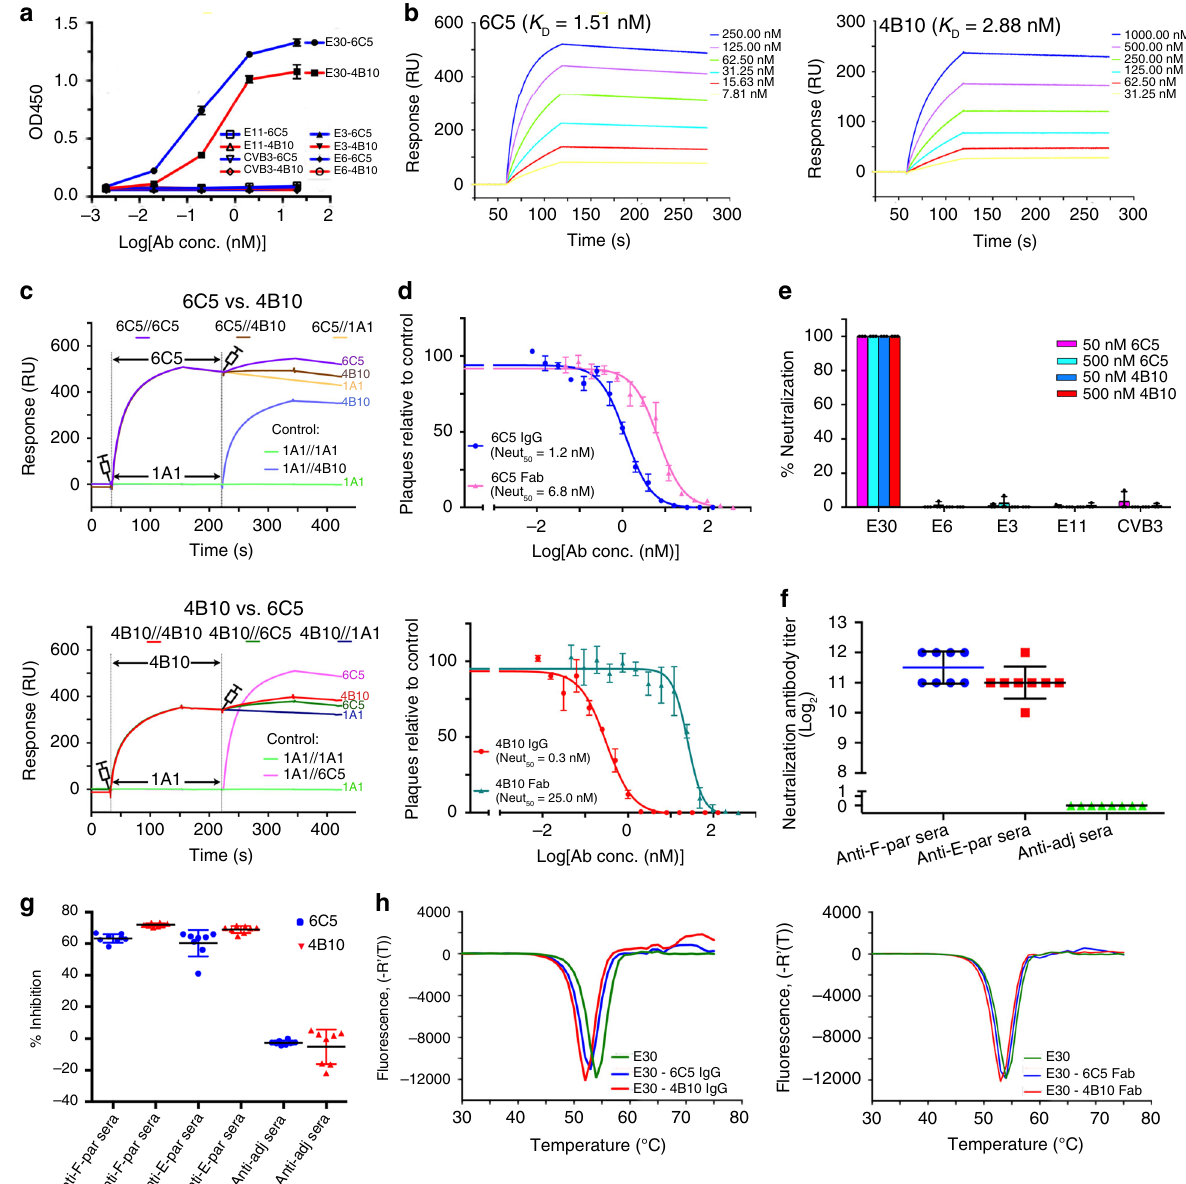
Fig. 1 Characterizations of the MAbs 6C5 and 4B10. a Dose-dependent binding analysis of MAbs (6C5 and 4B10) against representative enterovirus B members by ELISA. Each plot represents the mean of OD450 values from triplicate wells. Error bars represent mean ± SD. b BIAcore SPR kinetic pro fi le of MAb 6C5 (left) and 4B10 (right) against E30 virus. The binding af fi nity K D (equilibrium dissociation constant, K D = K d / K a , where K d and K a represents the dissociation rate constant and association rate constant, respectively) values were obtained by using a series of MAb concentrations and fi tted in a global mode in each sensorgram. c Competitive binding between 6C5 and 4B10. In the upper panel, MAb 6C5 was injected fi rst, followed by the second injection of 4B10 or 1A1 speci fi c to E6 as control. In the lower panel, 4B10 was injected fi rst, which was followed by 6C5 or 1A1; the control groups are carried out as the other lines exhibit. d Neutralization of E30 by 6C5 (top) and 4B10 (bottom) using plaque-reduction neutralization test (PRNT). Neut 50 values indicate concentration of antibody required to neutralize fi fty percent of the viral titer. The Neut 50 of 6C5 IgG, 6C5 Fab, 4B10 IgG and 4B10 Fab were 1.2 nM, 6.8, 0.3 and 25.0 nM, respectively. e Neutralization test of MAbs against representative enterovirus B members by PRNT. An amount of 50 nM/500 nM of 6C5 or 4B10 was used to test whether these two antibodies could cross-neutralize other enterovirus B members. f Titration of sera from mice immunized with E30 F-particle or E-particle. Both antisera could highly neutralize E30, while the sera from adjuvant-immunized mice failed to protect RD cells from E30 infection. g Competitive ELISA. The antisera against E30 F-particle, or E-particle or adjuvant (as control) was fi rst added to E30 to try to block the binding of E30 with 6C5 or 4B10 added later. h Stabilities of E30 upon addition of 6C5 or 4B10. The whole antibodies of 6C5 and 4B10 in complex with E30 (left), as well as their corresponding Fab parts in complex with E30 (right) were mixed with SYTO9 to detect the exposed viral RNA when a heat gradient was applied. All results in a , d – g were expressed as mean ±